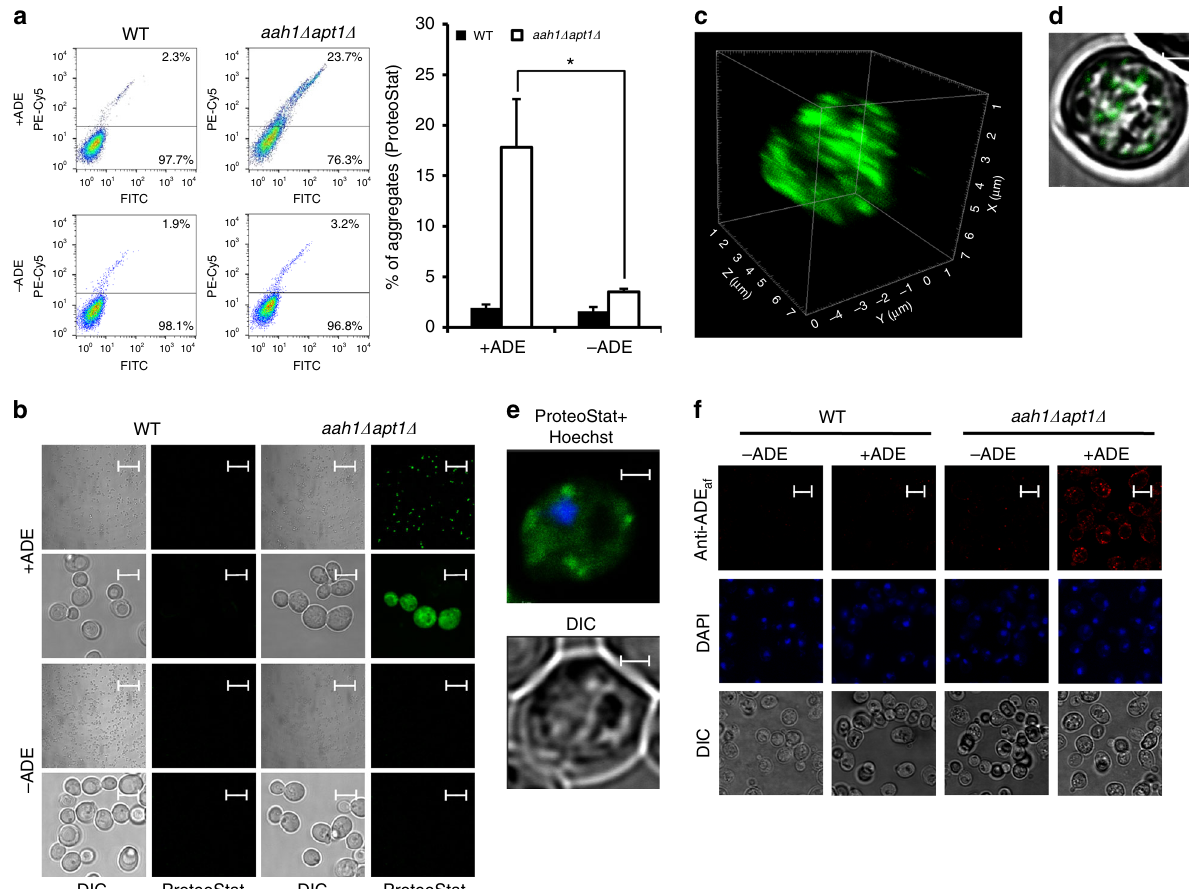
Fig. 3 In vivo formation of amyloid-like structures upon adenine feeding. a and b Flow cytometry analysis ( a ) and representative confocal and differential interference contrast (DIC) images ( b ) of WT and aah1 Δ apt1 Δ cells under the indicated conditions using ProteoStat staining. * P < 0.01 (Student ’ s t -test). Values are the mean ± s.d. of three experiments. Scale bars are 50 and 5 μ m for the lower ( fi rst and third lines) and higher resolution (second and fourth lines) images. c and d Z-stack followed by 3D reconstruction ( c ) and projection of a single section ( d ) of aah1 Δ apt1 Δ cells using ProteoStat. The analysis was performed using the Imaris software. Scale bar in ( d ) is 1 µ m. e Representative image of aah1 Δ apt1 Δ cells double-stained with Hoechst and ProteoStat. Cells were visualized using DIC microscopy. Scale bar is 1 µ m. f Representative confocal and differential interference contrast (DIC) images of WT and aah1 Δ apt1 Δ cells under the indicated conditions. Cells were fi xed and subjected to indirect immuno fl uorescence using a polyclonal antibody raised against adenine amyloid-like assemblies, designated as Anti-ADE af ( = amyloid fi brils) . Scale bar is 5 µ